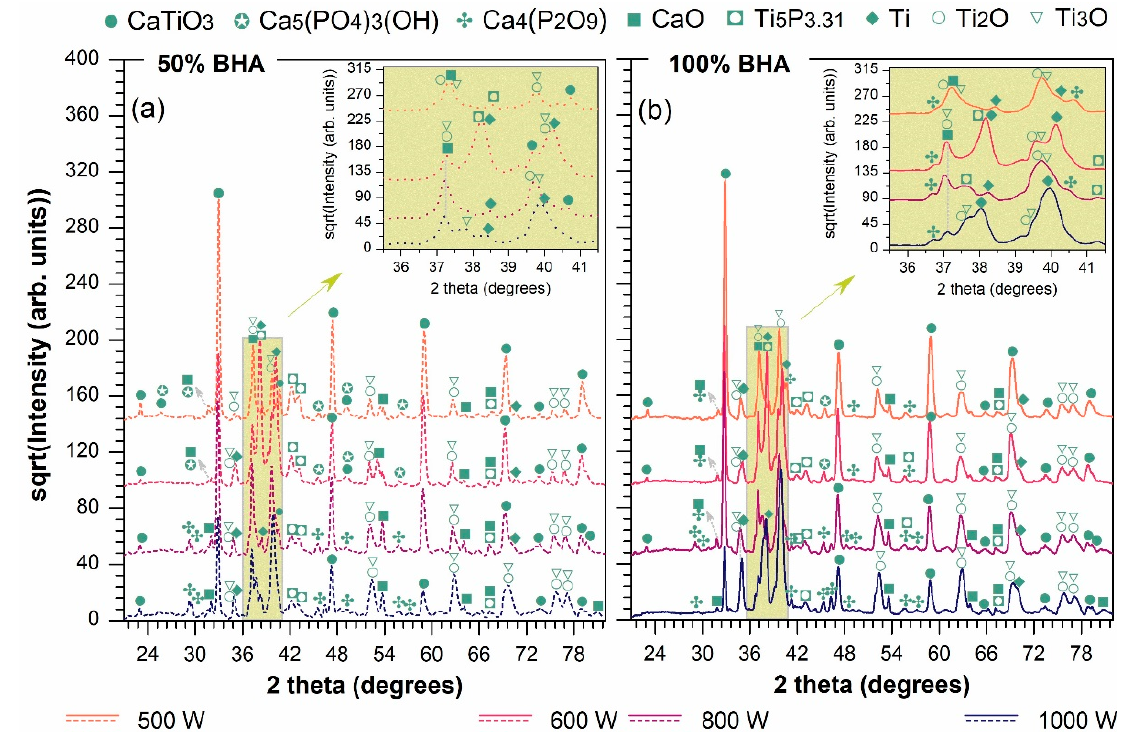
Figure 2. XRD patterns collected for the laser-cladded samples deposited using BHA powder contents of ( a ) 50 and ( b ) 100 wt.% at the four beam powers.